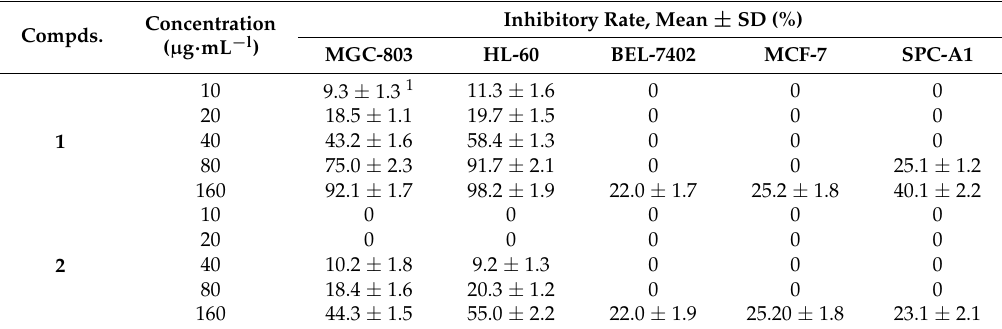
Table 3. The cytotoxicity of compouds 1 and 2 assayed by XTT assay (n = 3).